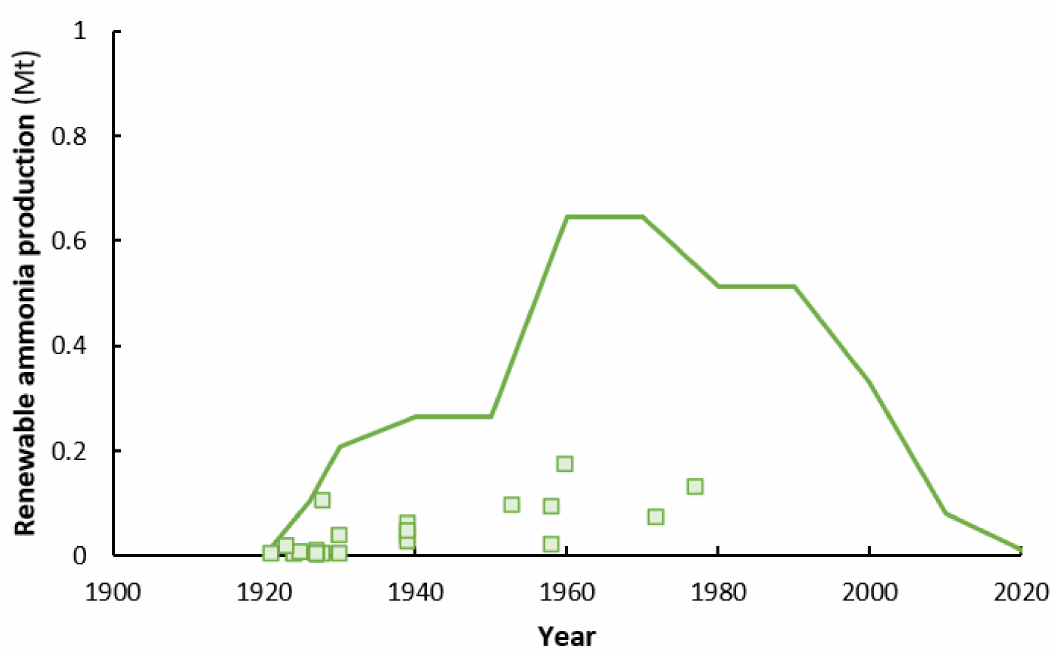
Figure 6. Global operational renewable ammonia capacity. Squares represent individual plants (see Table 2 and Table